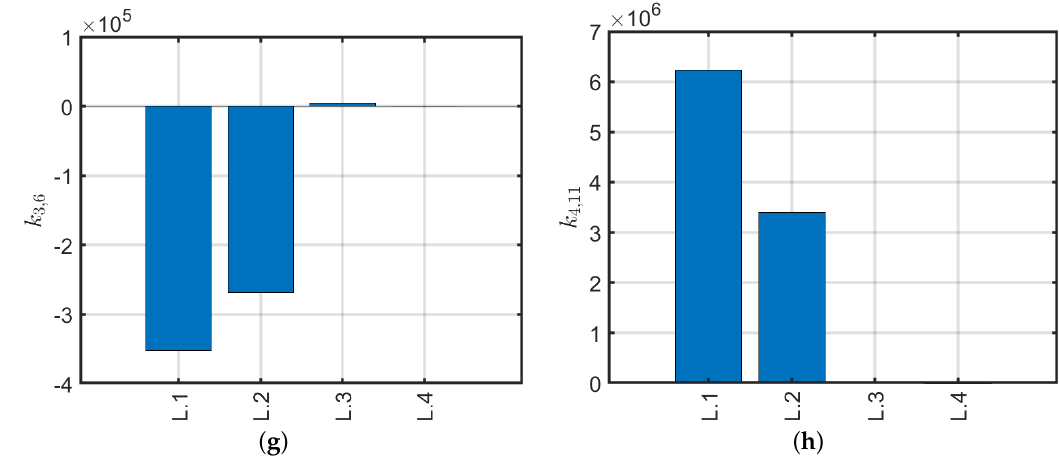
Figure 13. Stiffness components ( a – h ) of the considered Bouligand laminates for L = 1